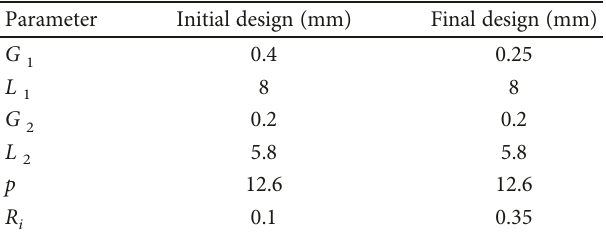
Table 1: Structure parameter of CSIW-CRLH.